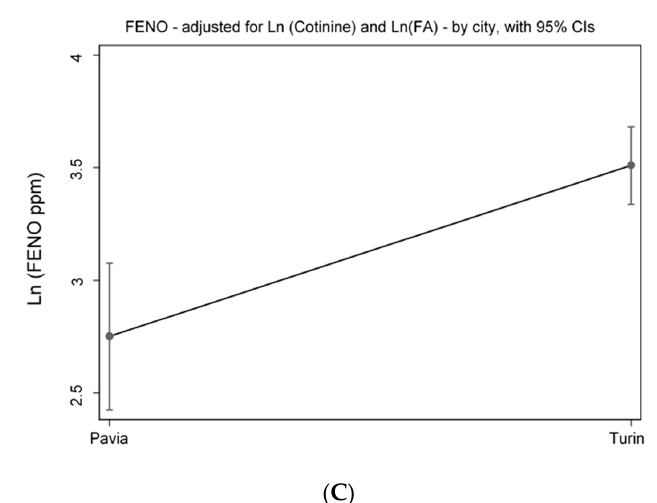
Figure 3. MLR model. Log (air-FA), in Turin and in Pavia, indoors and outdoors ( A ), Log (15 F2t-IsoP) ( B ) and log (FeNO) ( C ).